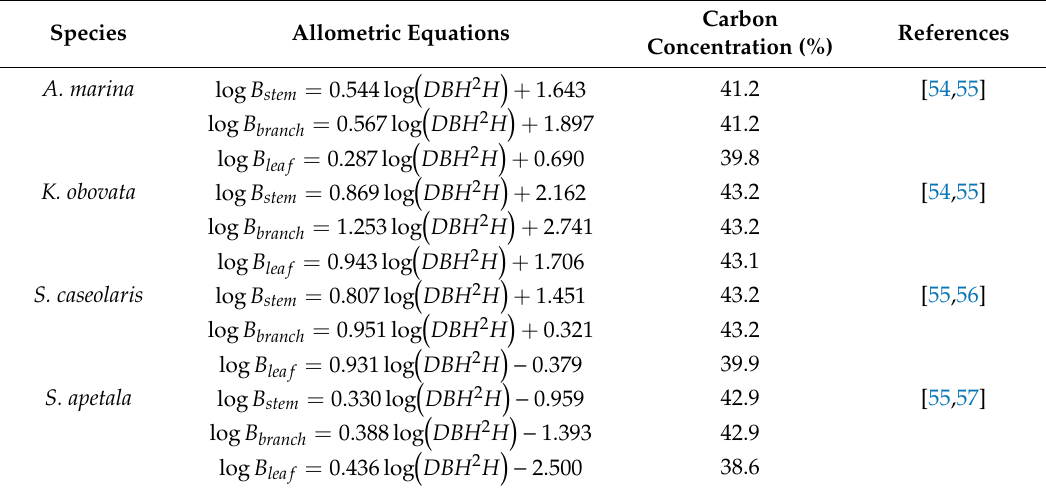
Table 1. Allometric equations and carbon content for calculating the aboveground carbon stacks of the mangrove species.